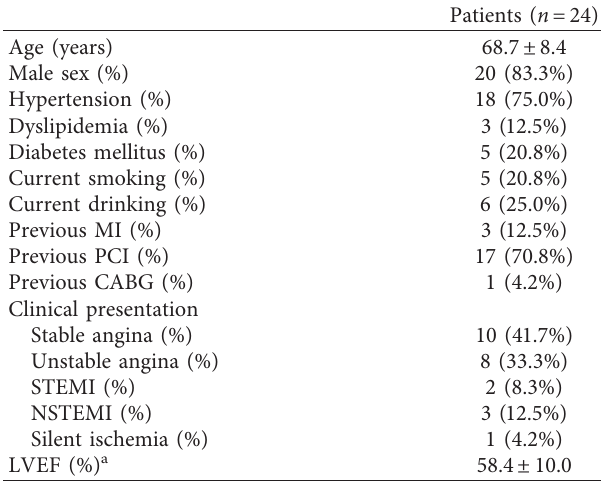
Table 1: Baseline clinical characteristics.